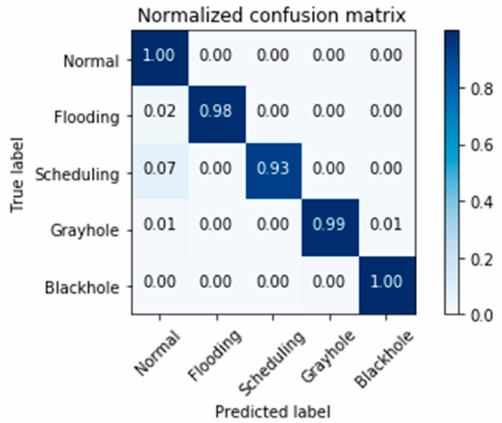
Figure 3. Confusion matrix of intrusion detection of the proposed GXGBoost model using holdout method on the WSN-DS Dataset. Table 9. Positive and negative rates results of the 10 fold cross validation. Normal